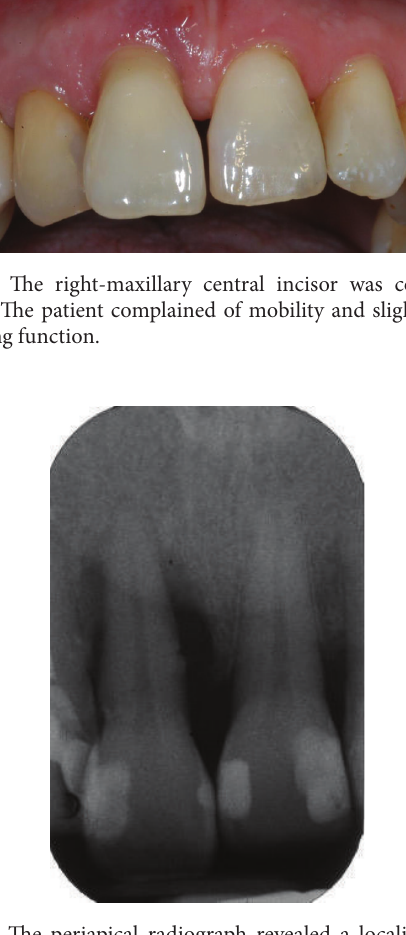
Figure 2: The periapical radiograph revealed a localized, severe bone resorption affecting the